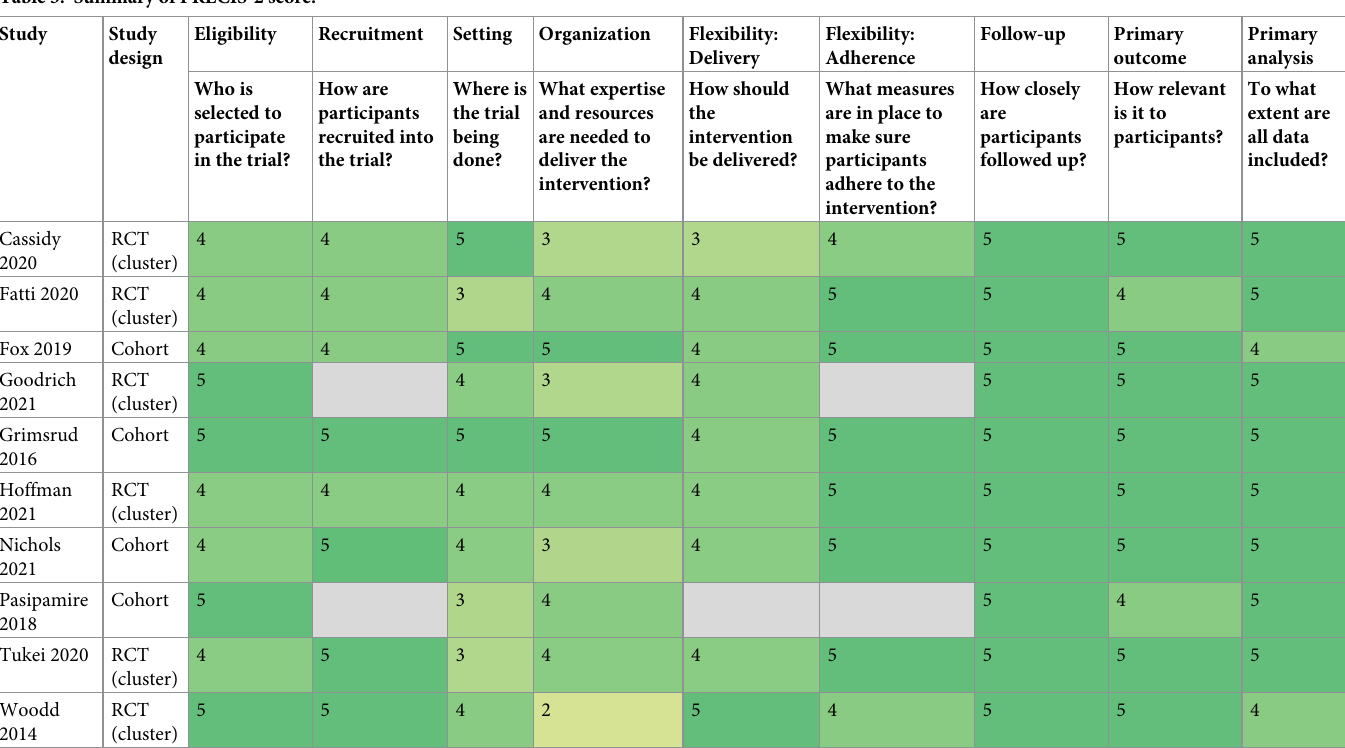
Table 5. Summary of PRECIS-2